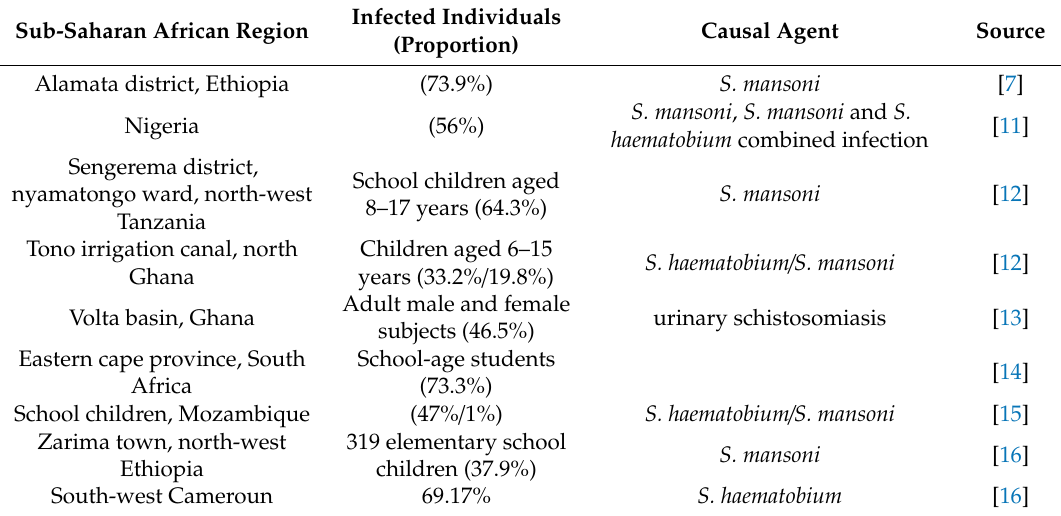
Table 1. Summary of African regions where schistosomiasis strikes